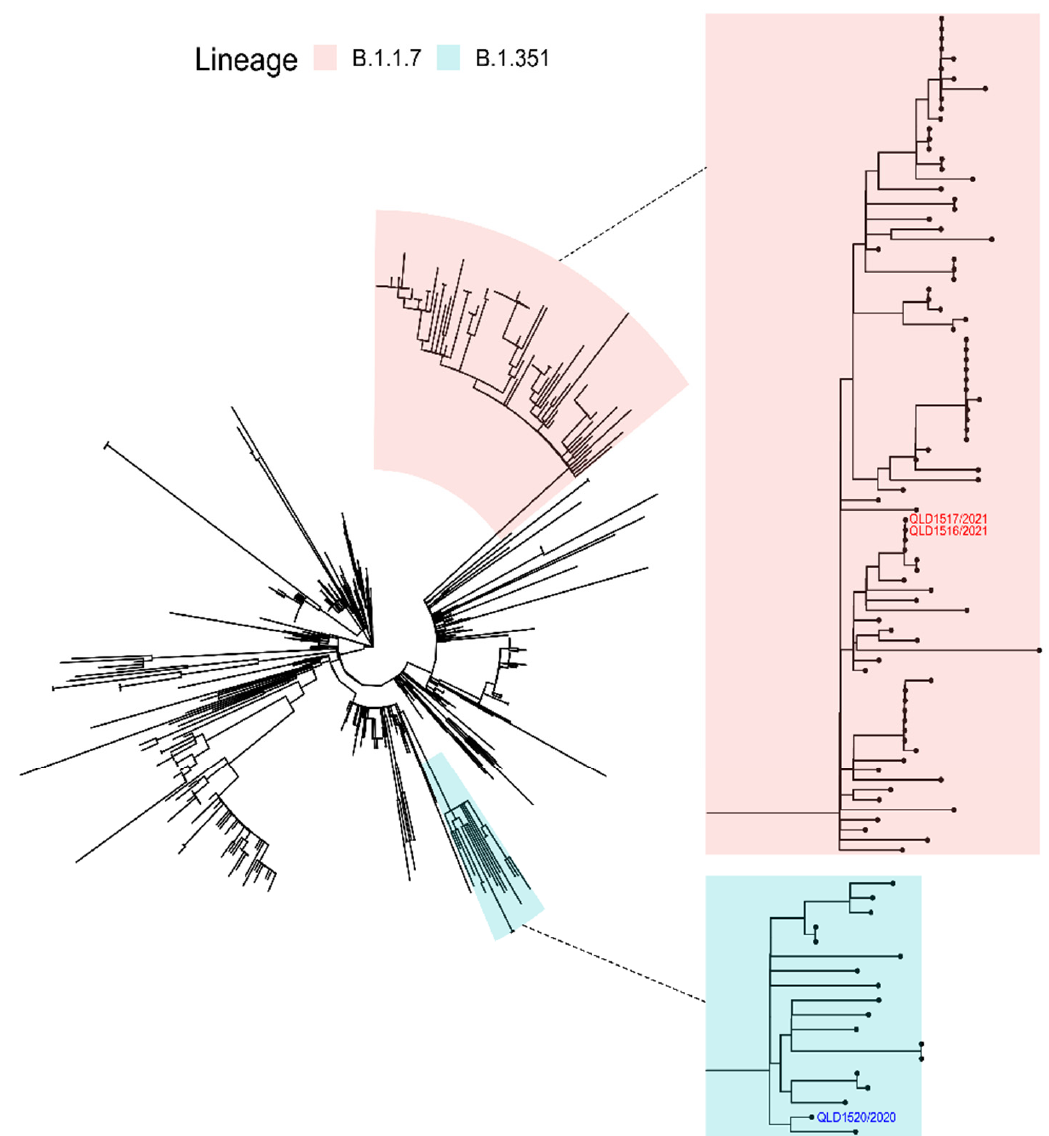
Figure 2. Maximum-likelihood tree inferred from 571 SARS-CoV-2 complete genome nucleotide sequences obtained in Queensland, Australia between January 2020 and mid-May 2021. The B.1.1.7 and B.1.351 lineages, together with the respective SARS-CoV-2 QLD1516/2021, QLD1517/2021, and QLD1520/2020 isolates, are highlighted. The insets attached to dotted lines show the B.1.1.7 and B.1.351 lineage clades at higher